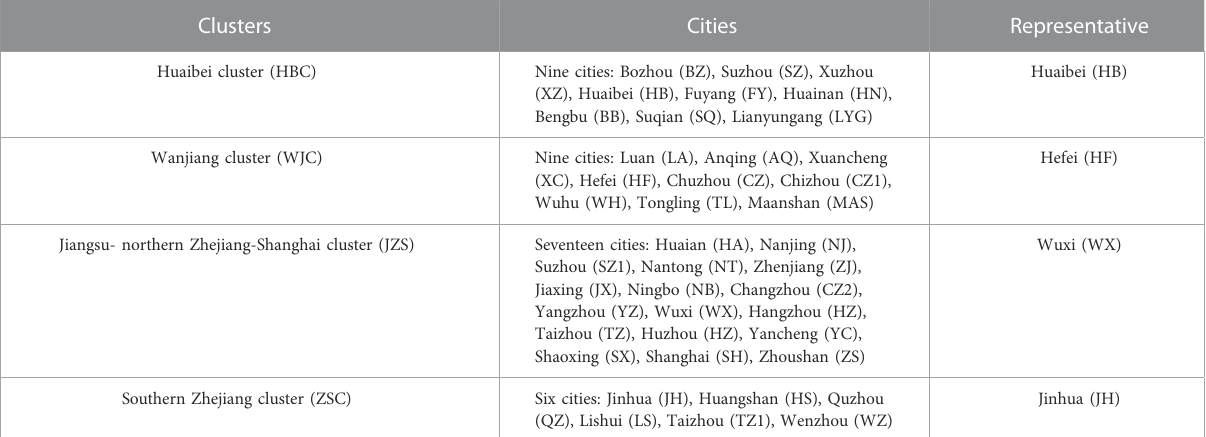
TABLE 1 Classi fi cation of urban agglomerations. Clusters Cities